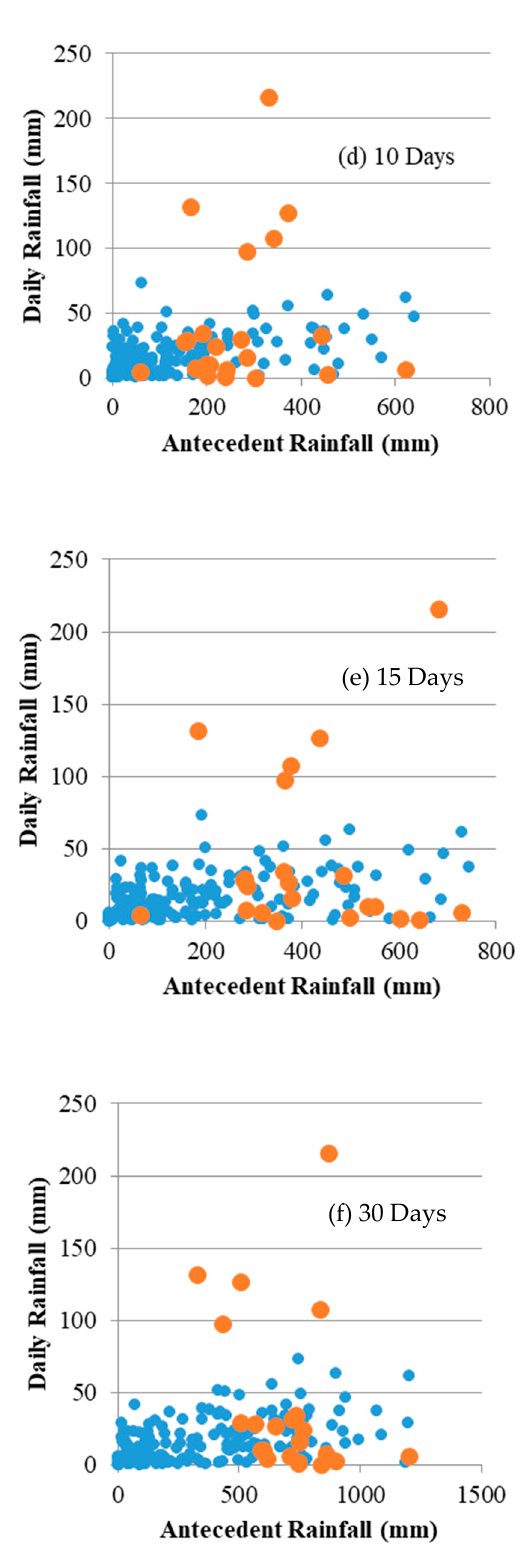
Figure 5. Relationship between daily (blue) and antecedent (orange) rainfall in 2014–2017. The threshold determination was performed using a scatter chart for daily (R TH ) and 30 day antecedent rainfall (R 30ad ), and was calculated for all three zones. The graph was generated using the rainfall and landslide data from 2014–2017. The threshold equation was obtained by using the lower